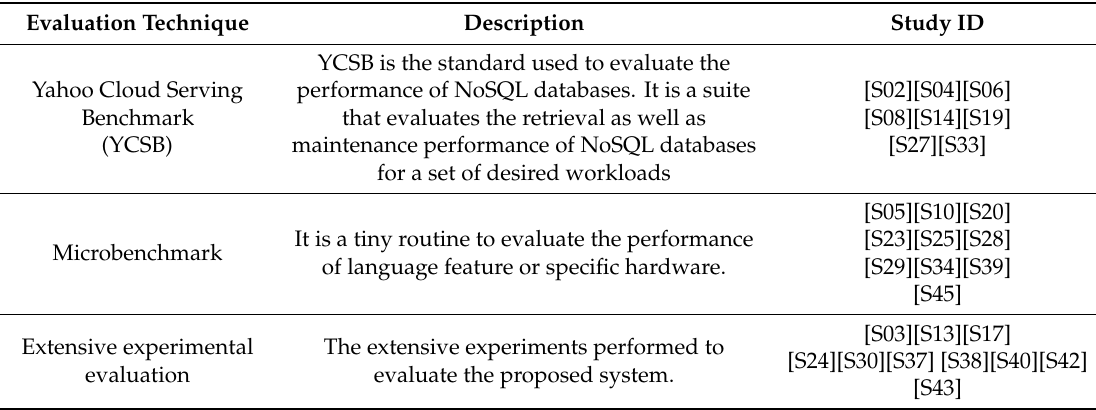
Table 8. List and description of evaluation